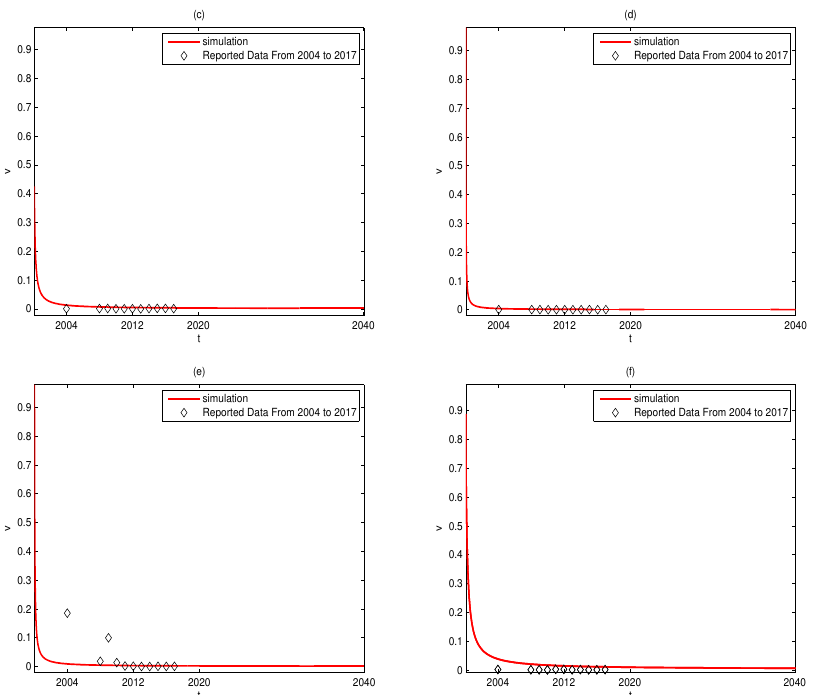
Figure 5. Predicted tendency of forest fire in HeiLongJiang, Inner Mongolia, JiLin, etc. ( a ) Number of forests in ShanXi. ( b ) Number of forests in LiaoNing. ( c ) Number of forests in JiLin. ( d ) Number of forests in Inner Mongolia. ( e ) Number of forests in HeiLongJiang. ( f ) Number of forests in